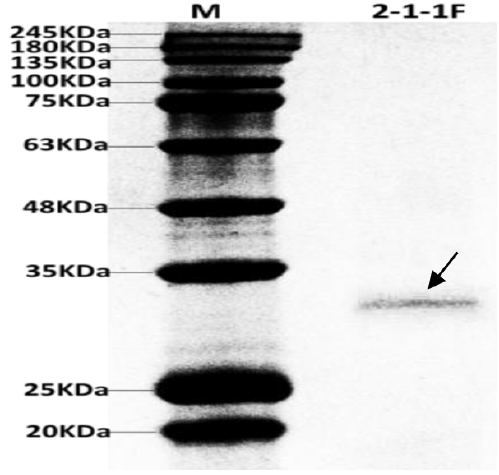
Figure 2. SDS-PAGE of antifungal protein 2-1-1F.